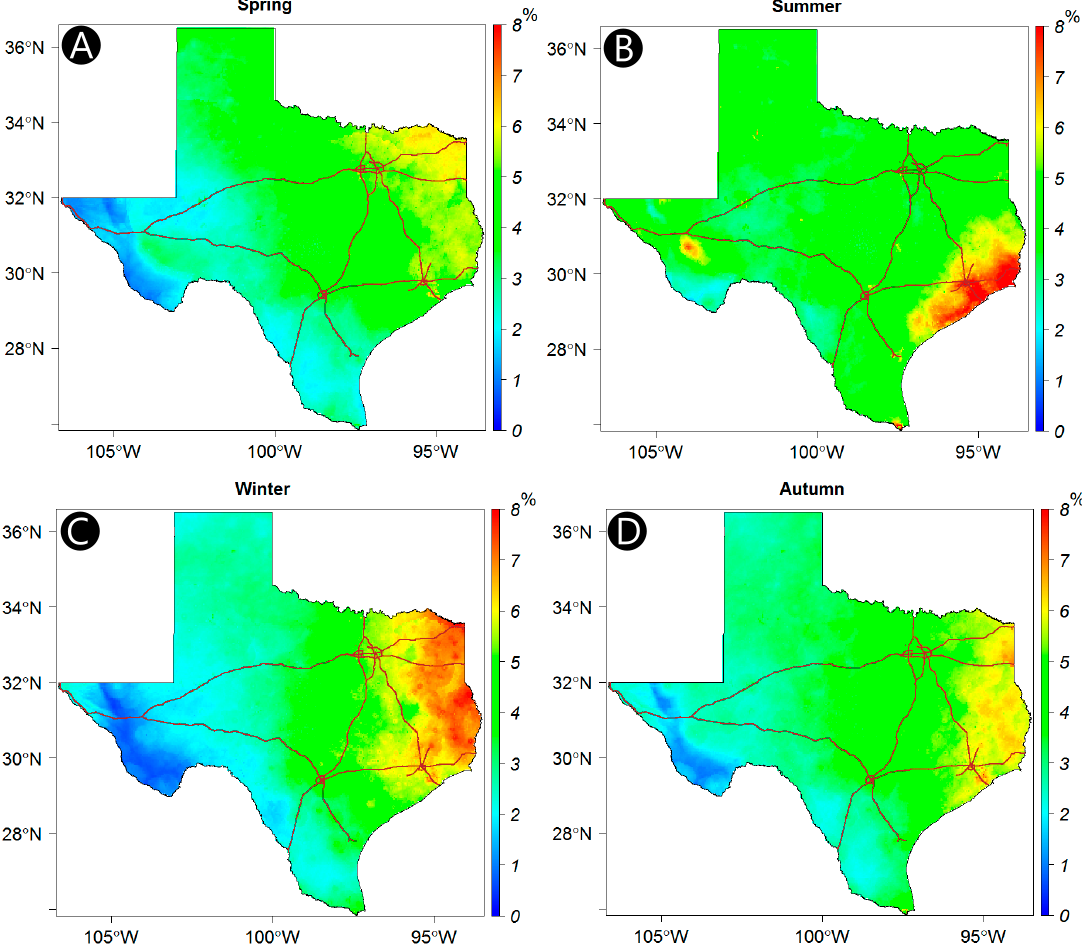
Figure 9. Spatial distribution of the average annual frequency of hourly precipitation for the four seasons in Texas ( A ) Spring; ( B ) Summer; ( C ) Autumn; ( D ) Winter (calculated from Hourly NEXRAD Stage IV data 2002–2019).